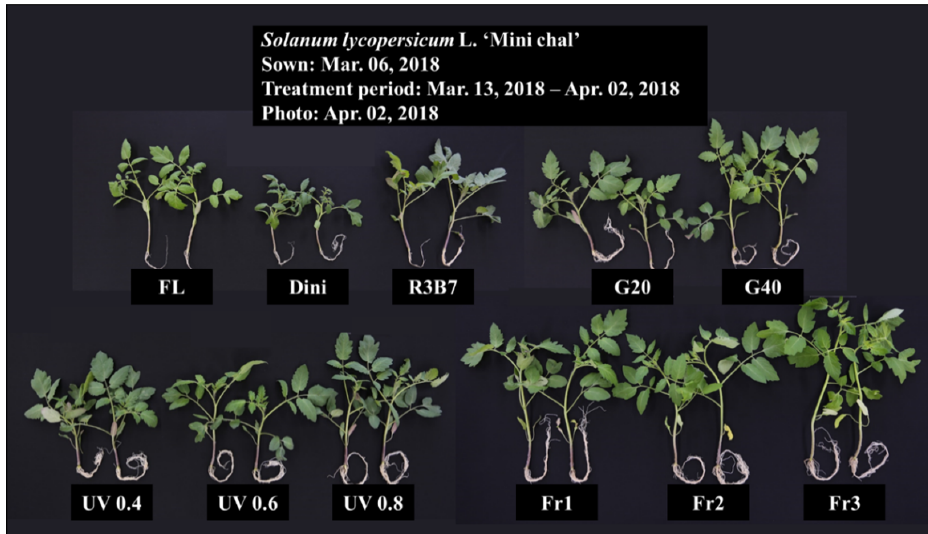
Figure 3. Plug seedlings of ‘Mini Chal’ tomato ( Solanum lycopersicum L.) treated with different light qualities at 21 days after start of treatment. Refer to Figure 1 for details on the light